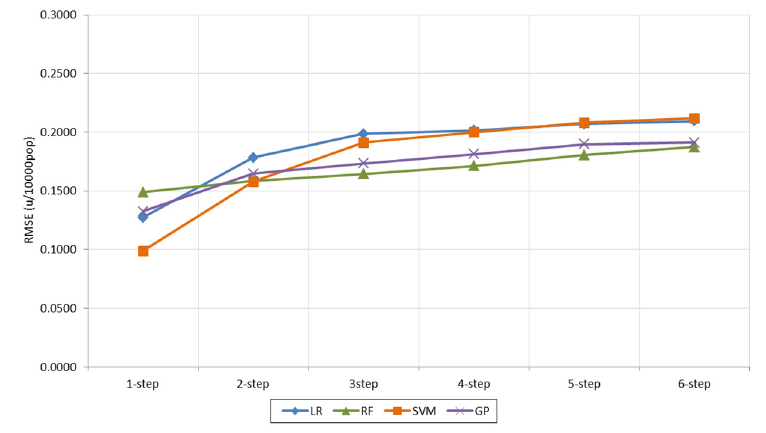
Figure 2. Comparative evolution of GBV complaints’ RMSE evolution obtained via an RF predictive algorithm with different FS techniques.